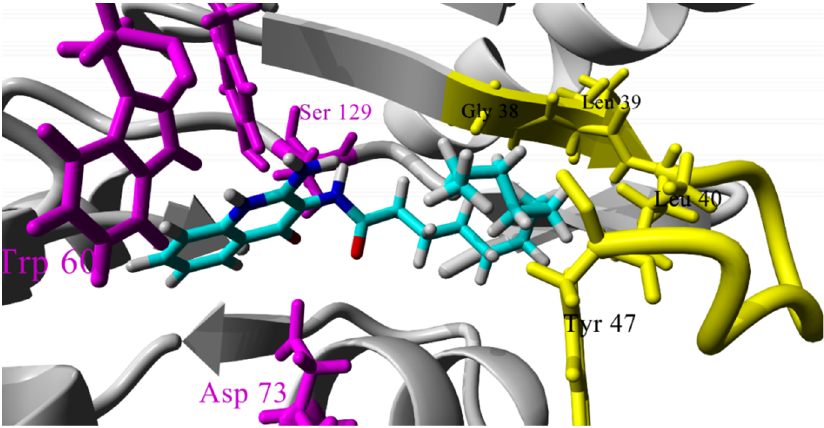
Figure 8. Docking pose for compound 4g in the active site of LasR. Residues of the hydrophilic pocket that form hydrogen bonds with natural ligand AHL are shown in magenta and those of Loop 3 are in yellow.